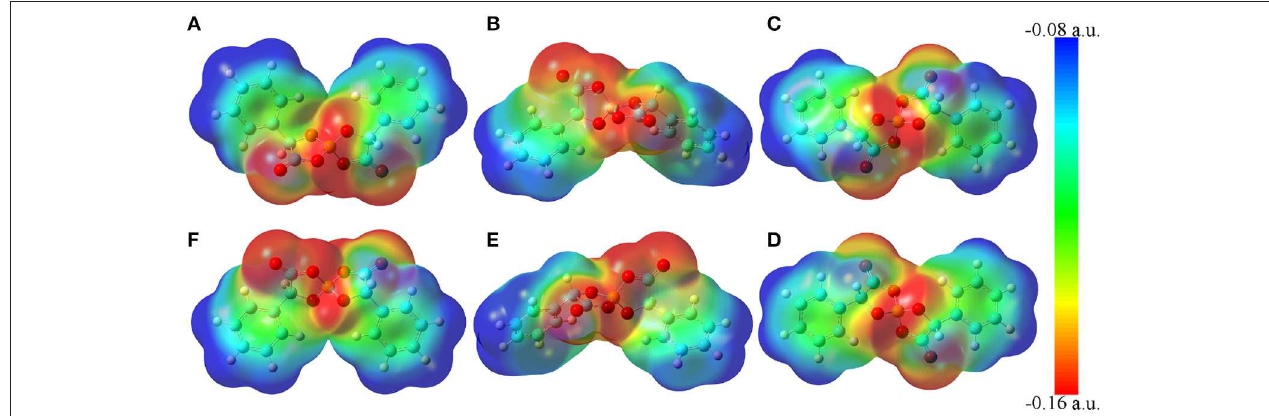
FIGURE 2 | Molecular electrostatic potential contours of six [BMB] conformers with different molecular chiralities obtained from DFT calculations. (A) B(R)-Man(RR), (B) B(R)-Man(RS), (C) B(R)-Man(SS), (D) B(S)-Man(RR), (E) B(S)-Man(SR), and (F) B(S)-Man(SS).